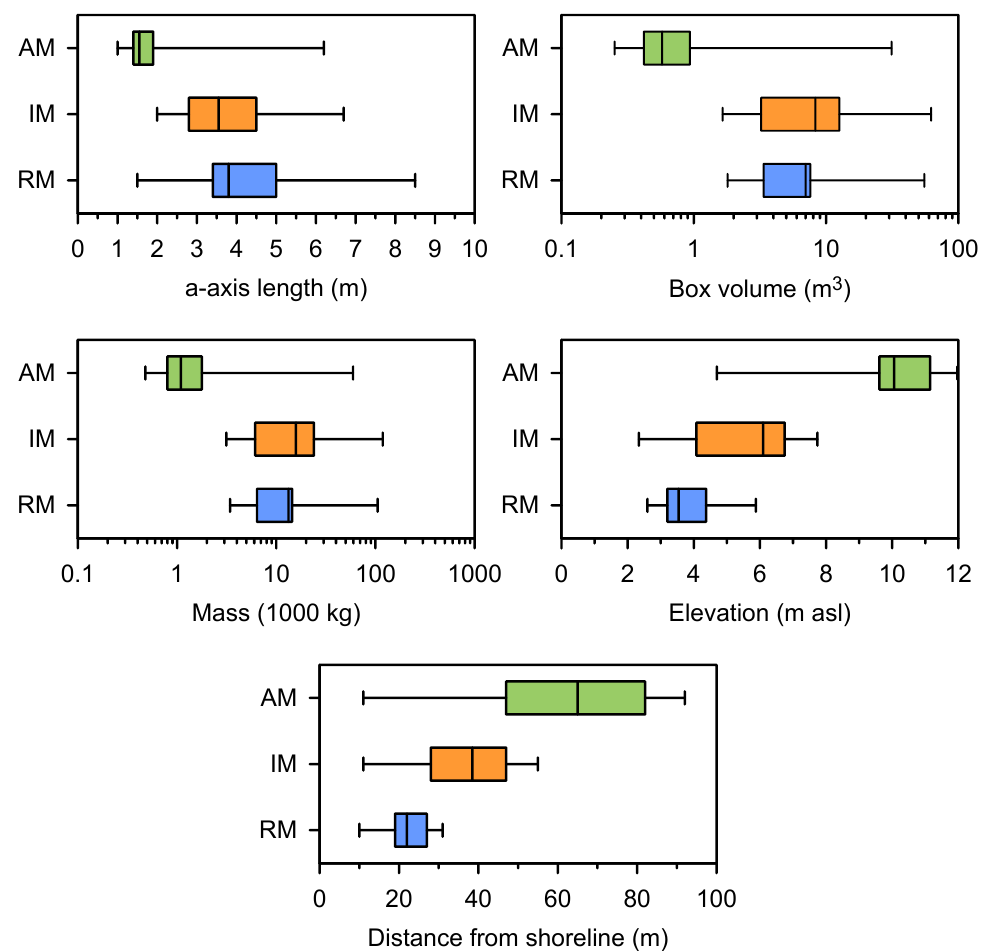
Figure 7. Box plots illustrating intrinsic (boulder) and contextual characteristics for the boulders of interest, classified as recent movers (RM), indeterminate movers (IM) and ancient movers